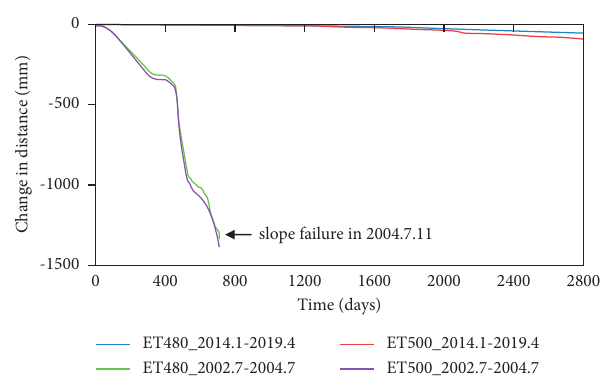
Figure 19: The change in distance from 2002.4 to 2004.7 and 2014.1 to